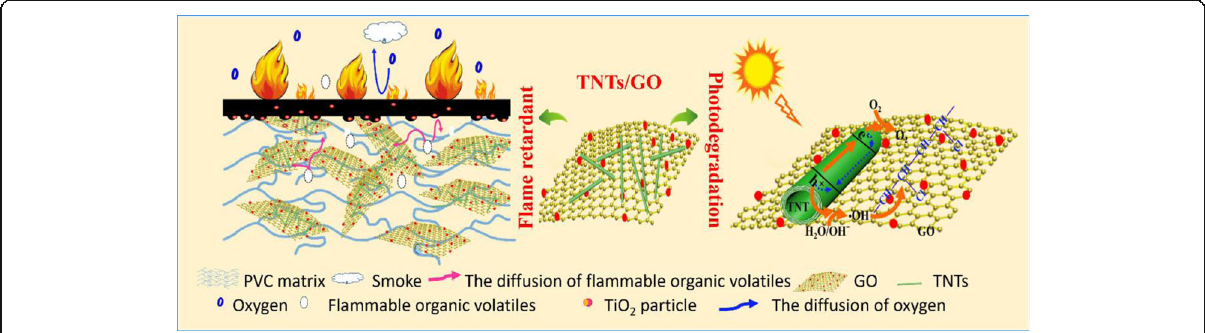
Fig. 9 Schematic illustration of flame-retardant and photocatalytic degradation mechanism of